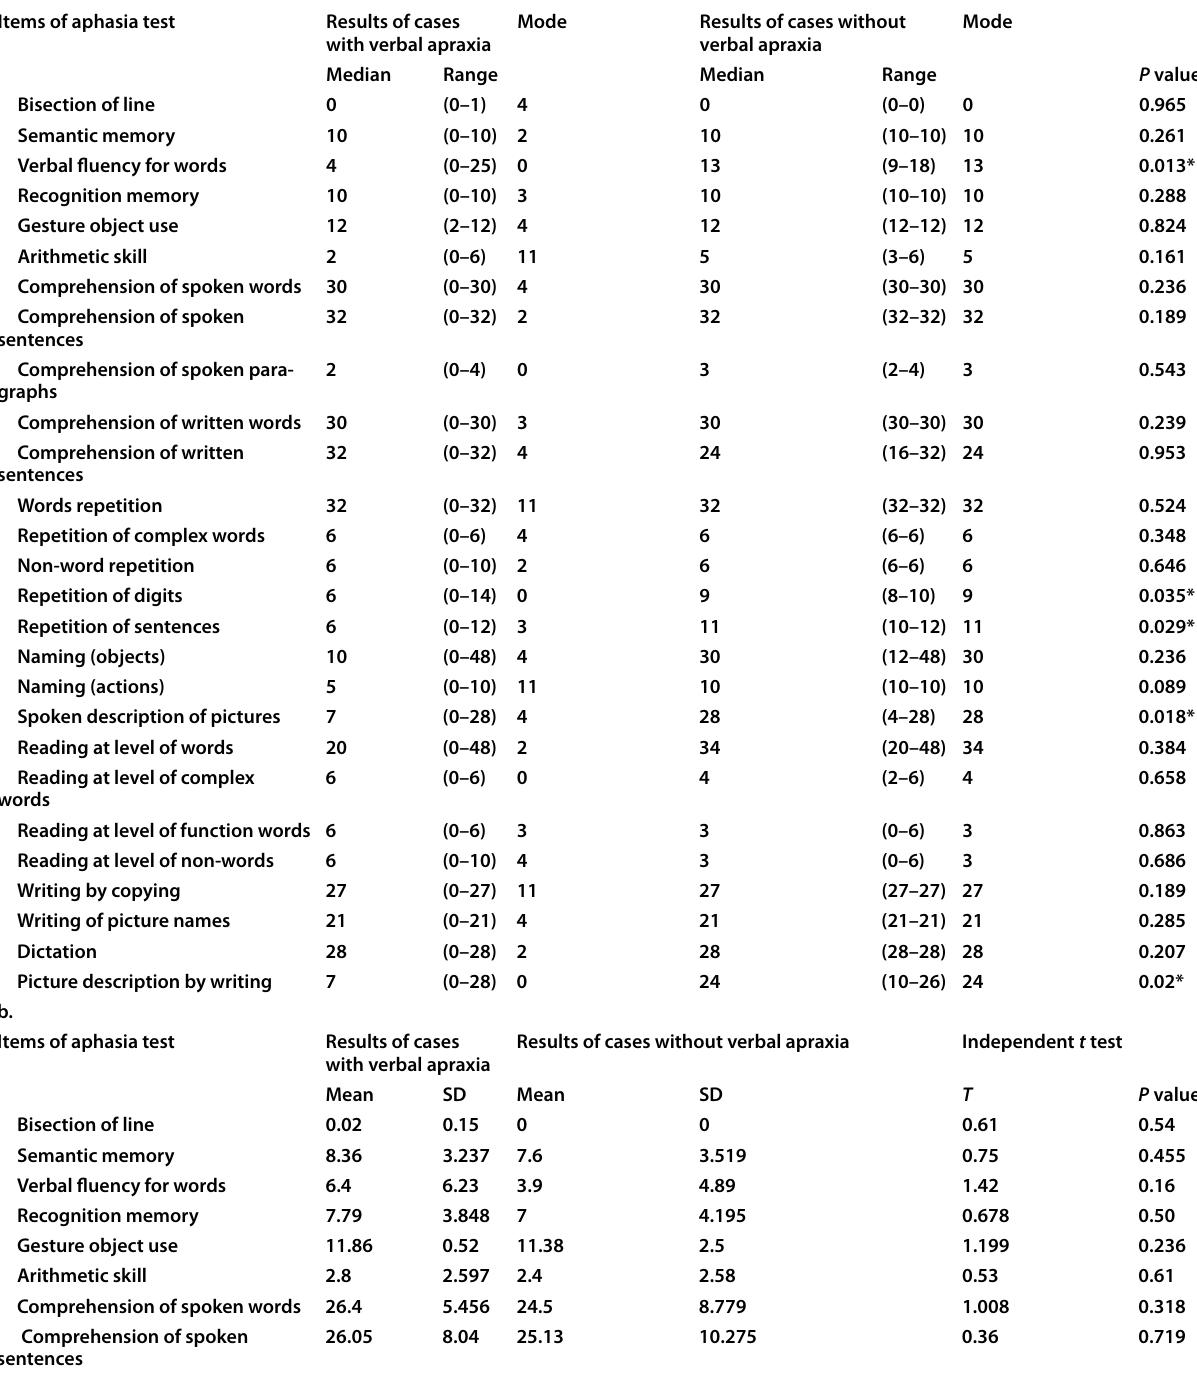
Table 1 Comparison between patients with verbal apraxia and without verbal apraxia regarding scores of aphasia test. Table 1 (a) that was statistically analyzed using the median shows that there was a significant difference between patients with verbal apraxia and patients without verbal apraxia in the scores of aphasia test except for word fluency, repetition of digit strings, sentence repetition, and spoken and written picture description. Table 1 (b) that was statistically analyzed using the mean reveals that there was a significant difference between patients with verbal apraxia and patients without verbal apraxia in the scores of aphasia test except for repetition of